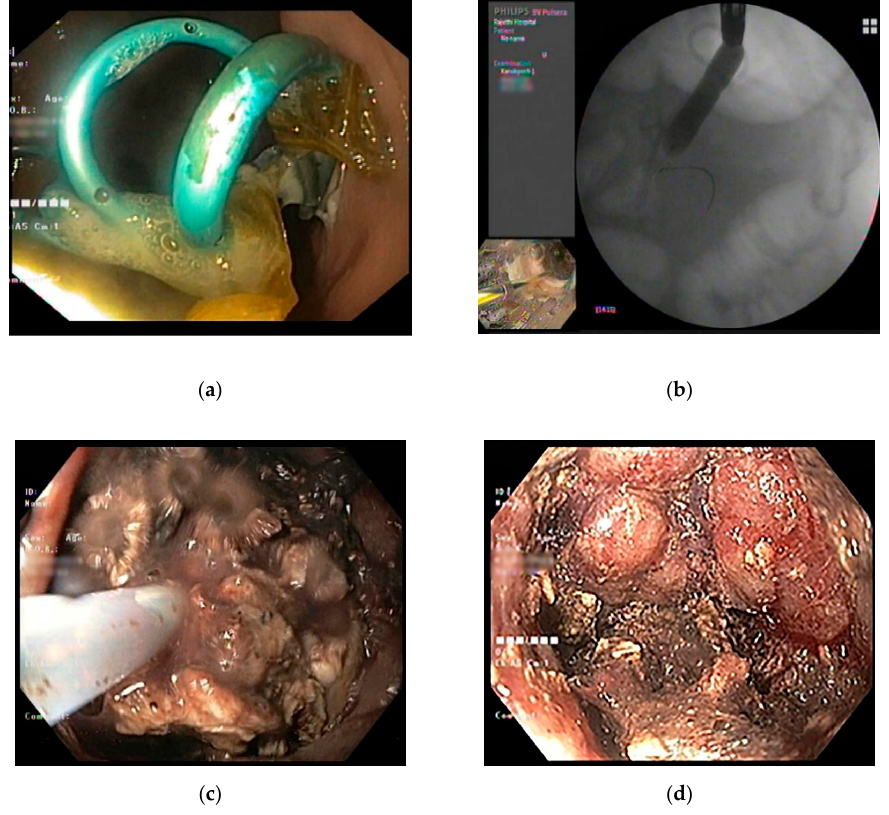
Figure 2. ( a ) Endoscopic necrosectomy after EUS-guided placement of multiple plastic stents. ( b